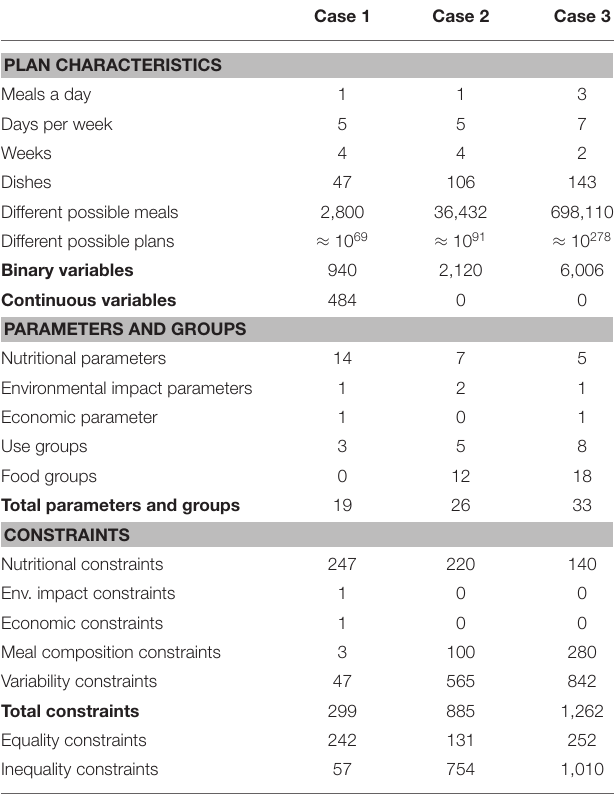
TABLE 1 | Indicators of the structure of the models used to design the meal plans in case 1, case 2, and case